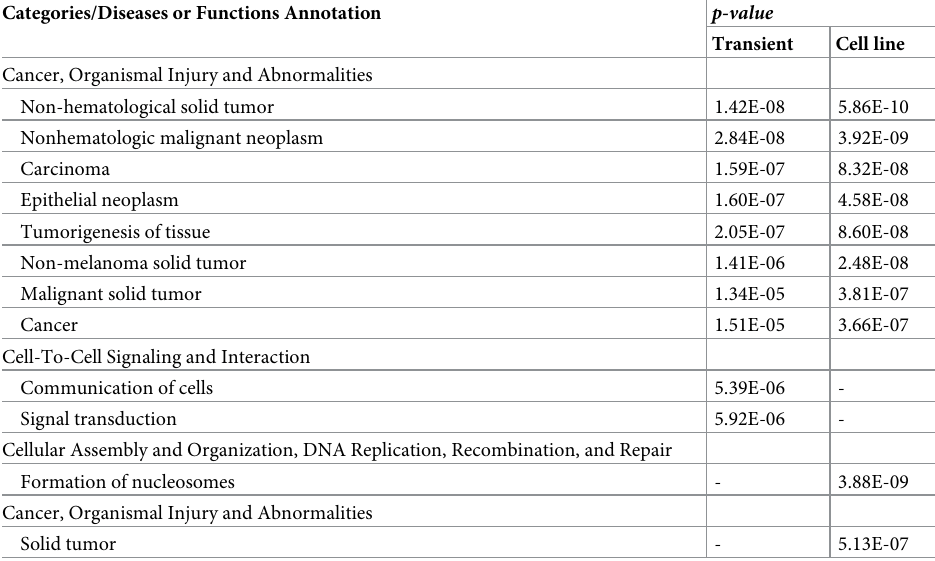
Table 1. Top 10 significant GO categories of KIKAT-regulated genes. Categories/Diseases or Functions Annotation Cancer, Organismal Injury and Abnormalities Non-hematological solid tumor